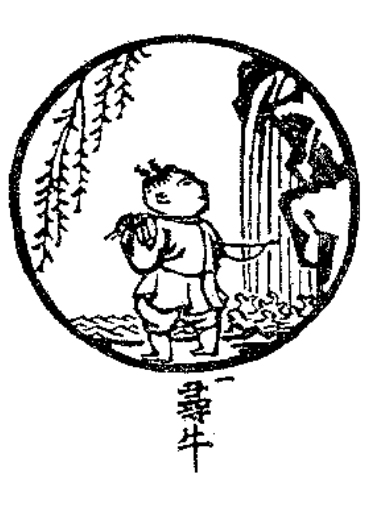
Figure 1. The Search for